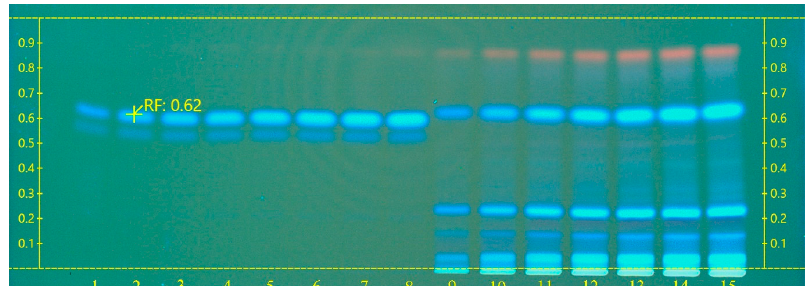
Figure 6. HPTLC chromatogram of L. schweinfurthii micropropagated leaves’ extract against ferulic acid standard captured at 366 nm. Tracks 1–8: ferulic acid, 400 µg ml − 1 of volume 2–9 µl; Tracks 9–15: dry leaves’ extract of volume 2, 4, 6, 8, 10, 12, and 14 µl.